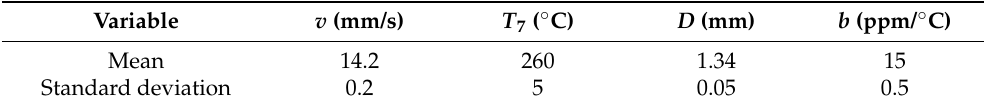
Table 4. Mean and standard deviation of each variable.